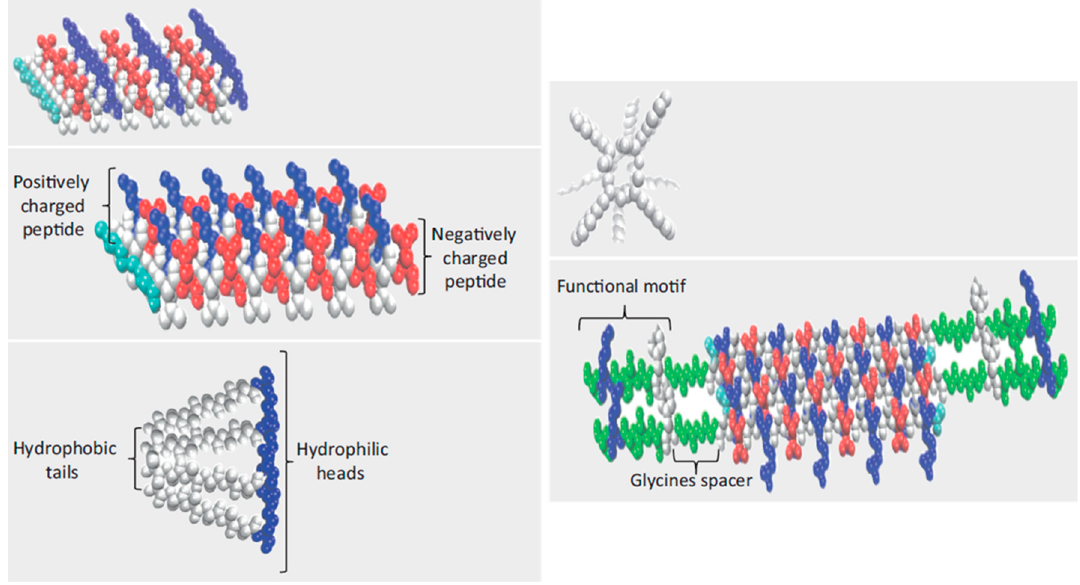
Figure 5. Typical structures of different self-assembled peptides: RADA-like SAPs, complementary coassembling peptides, peptide amphiphiles, cyclo-SAPs, and functionalized SAPs. Reproduced with permission from [121], copyright 1995 Elsevier.